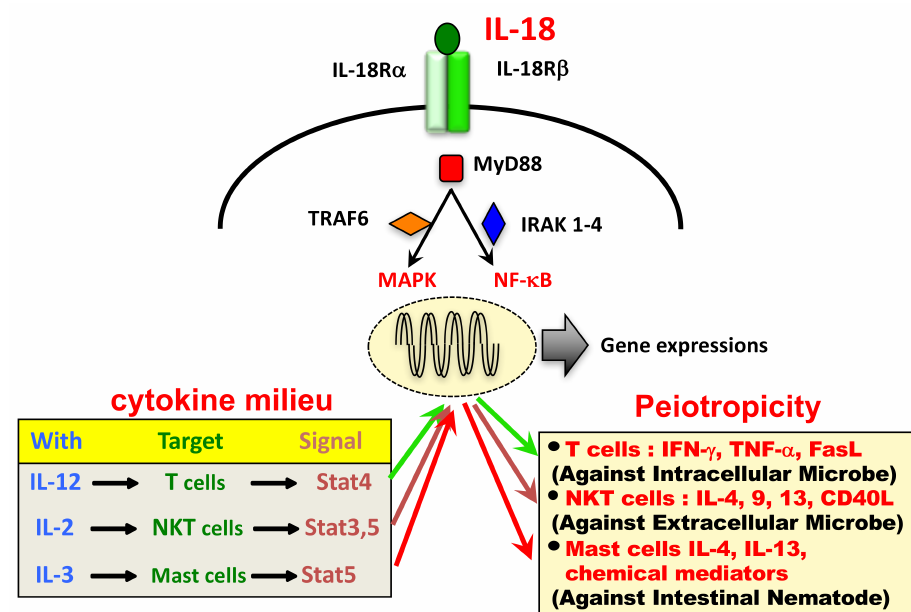
Figure 1. Pleiotropic action of IL-18 depends on its cytokine